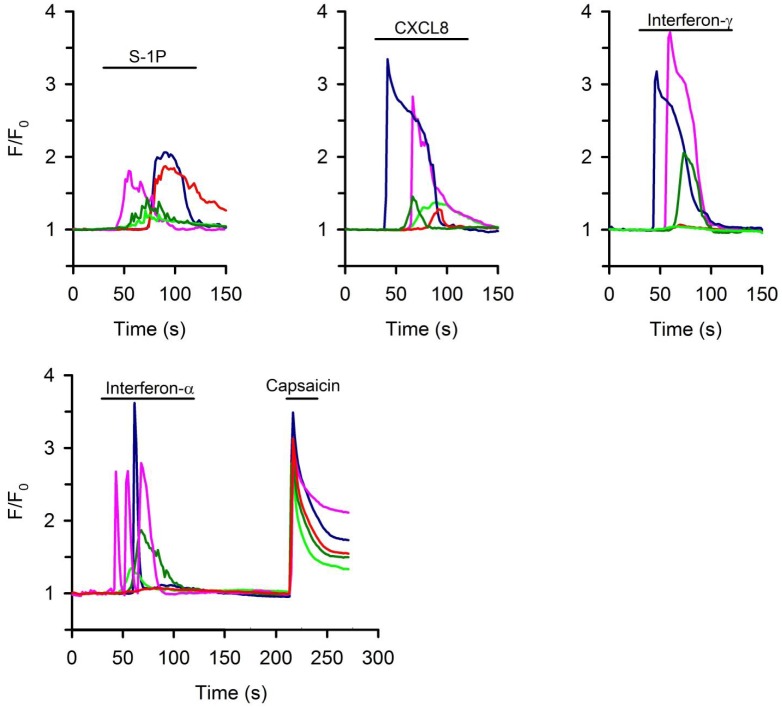
Response of isolated vagal sensory neurons to interferon-α (1000iu/ml) interferon- γ (200 ng/ml) CXCL8 (100ng/ml), and S-1P (10 μM) in a calcium assay.The vagal neurons were isolated from Pirt-GCaMP3 heterozygote mice in which the genetically encoded Ca2+ indicator GCaMP3 is expressed under the sensory neuron-specific Pirt promoter. Capsaicin sensitivity was determined at the end of the experiment by adding 1 μM capsaicin. The capsaicin response is shown in the experiments with interferon-α to provide some insight into efficacy of the mediator responses relative to a maximal capsaicin response. Different colors indicate response in different representative neurons (Total of N>100 neurons were tested in each condition). F/F0: The intensity of whole-cell fluorescence for each cell under study as a function of time, normalized to the resting fluorescence.